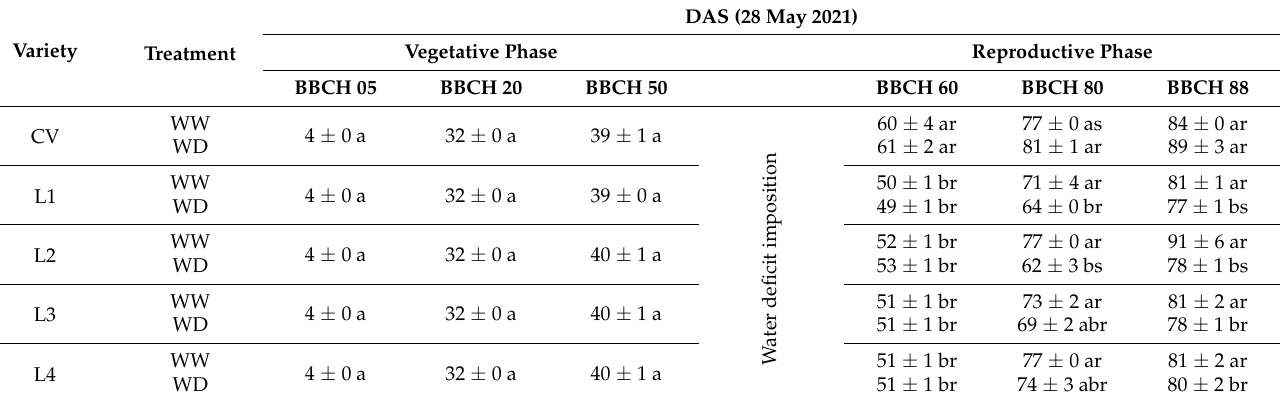
Table 3. Analysis of the phenological development of Portuguese cowpea plants, represented by the number of days after